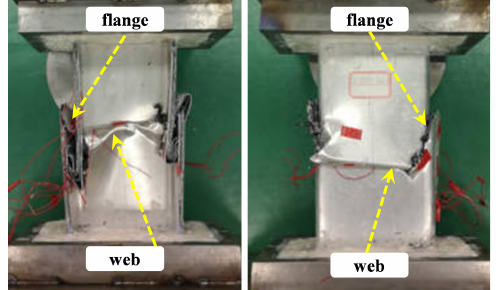
Figure 7: Typical failure modes of DCYG-A- and DCYG-B-type speci-